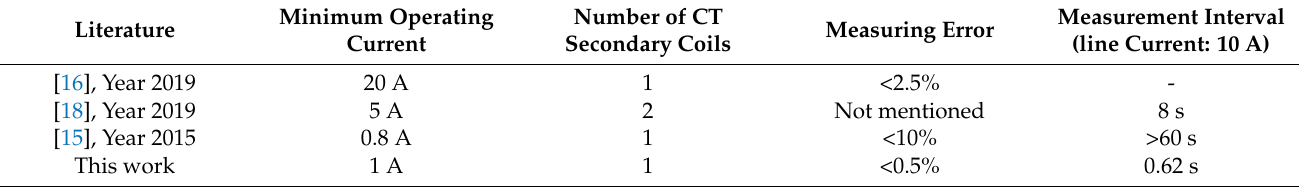
Table 3. Performance